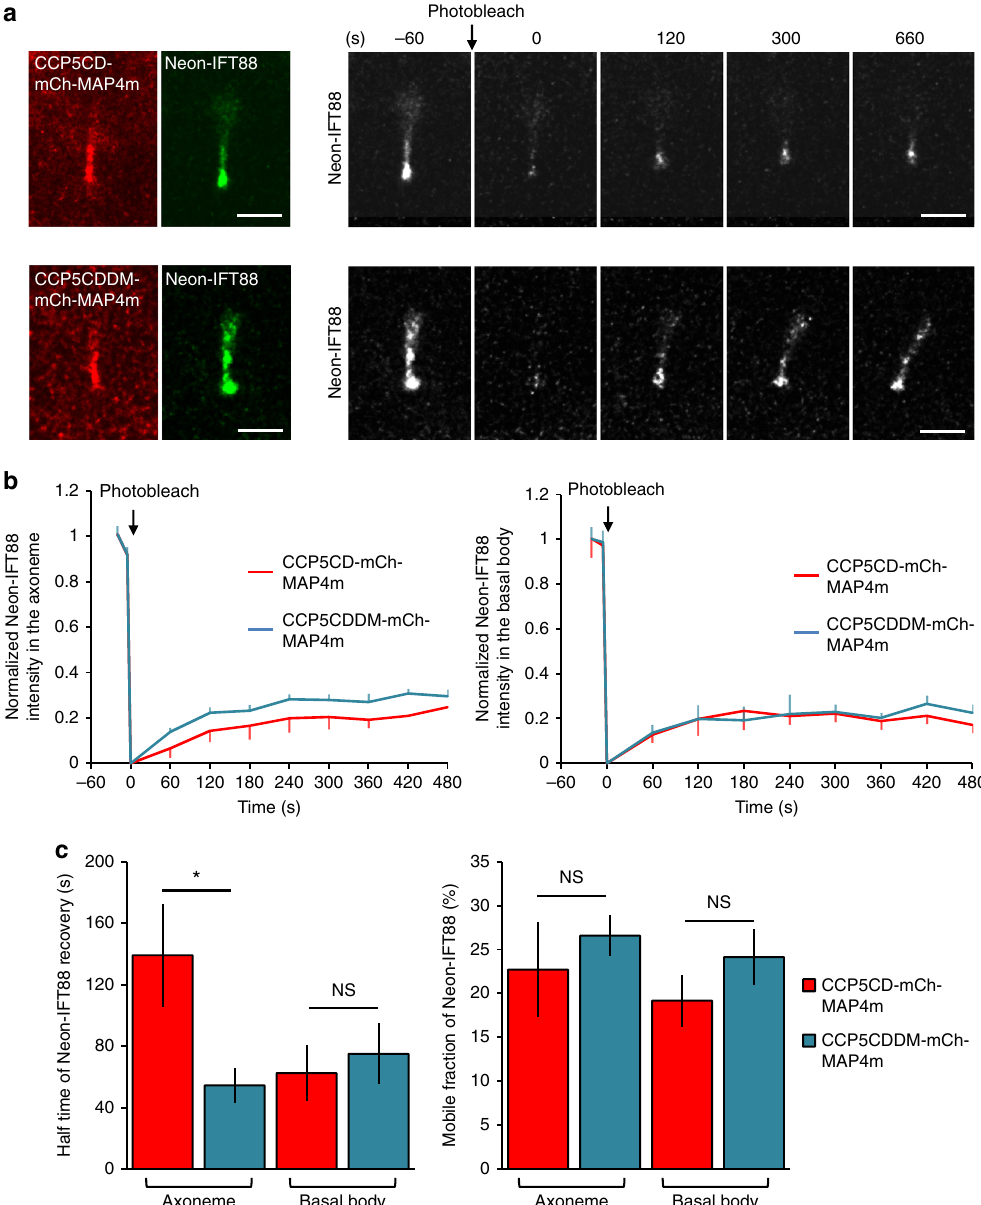
Fig. 5 Axonemal deglutamylation hampers IFT dynamics along the axoneme but not the tethering of IFT machinery on the basal body. a Neon-IFT88-stable NIH3T3 cells were transfected with CCP5CD – mCherry – MAP4m or catalytically inactive CCP5CDDM – mCherry – MAP4m. Transfected cells at 80 – 90% con fl uency were serum-starved for 24 h prior to FRAP experiments. Cells expressing the indicated proteins were photobleached in the entire cilia region and allowed to recover for the indicated times. Scale bar, 2 μ m. b Fluorescence recovery of Neon-IFT88 in the axoneme region (left) and basal body (right) was measured and plotted. c The recovery rate (left) and mobile fraction (right) of Neon-IFT88 in the axoneme and basal body were measured and plotted. Data represent the mean ± s.e.m. ( n = 9 and 13 cilia for the CCP5CD – mCherry – MAP4m and CCP5CDDM – mCherry – MAP4m groups, respectively; four independent experiments). NS and * indicate no signi fi cant difference and P < 0.05, respectively, between the CCP5CD-mCherry-MAP4m and CCP5CDDM-mCherry-MAP4m groups (Student's t